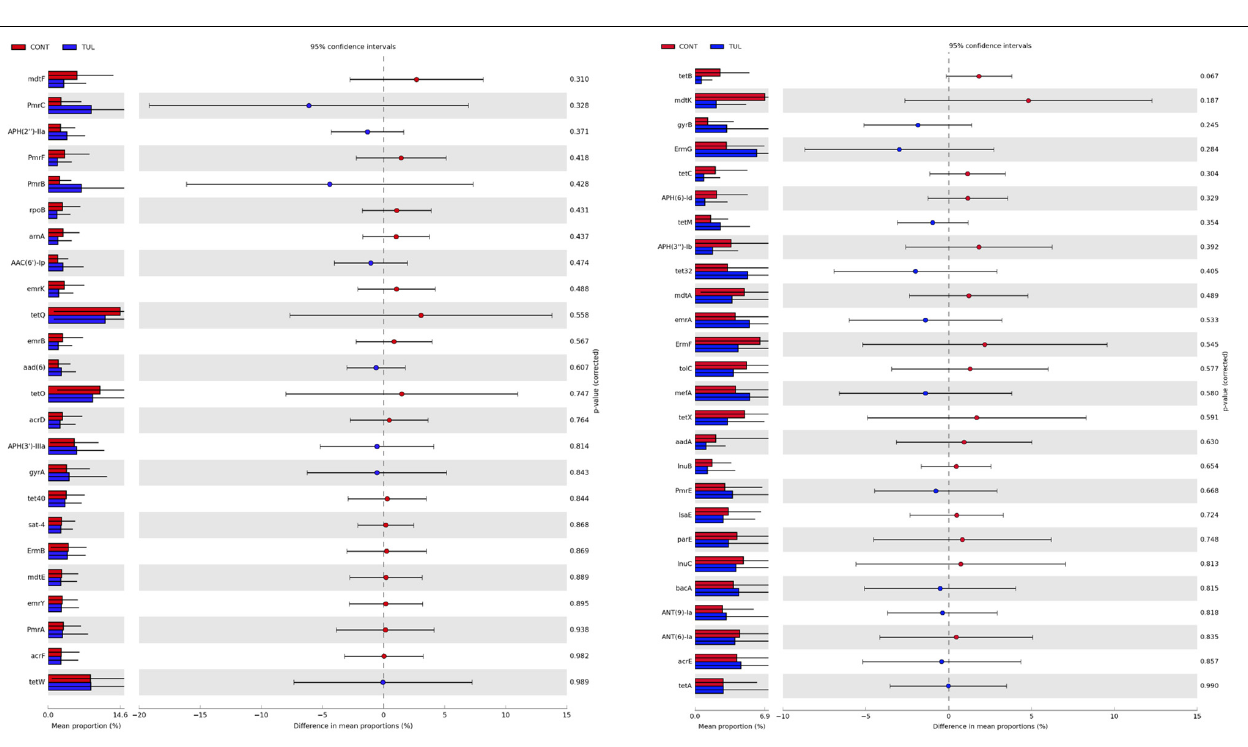
Frontiers in Microbiology |